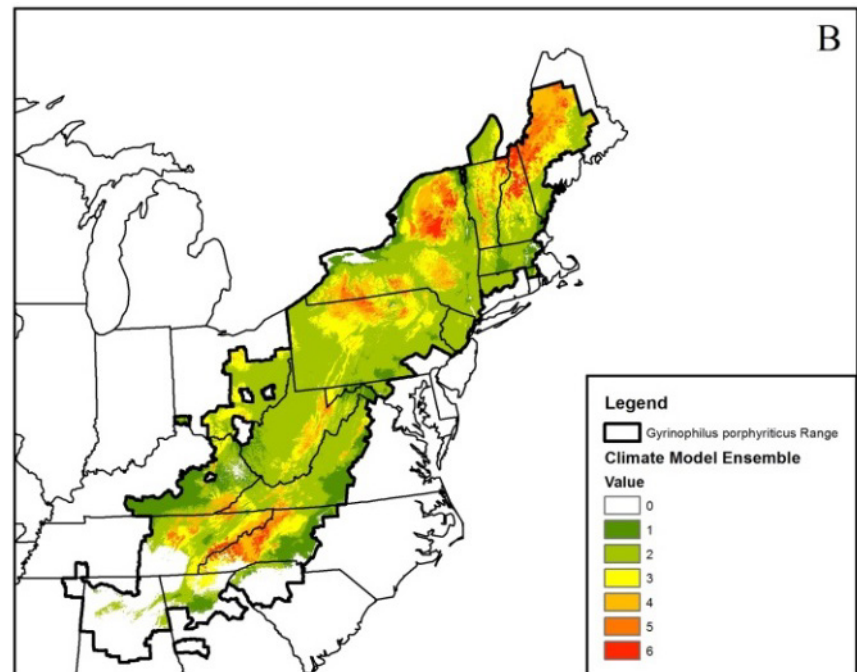
Figure 2. Ensembled climatic distribution within the known geographic range (area with the dark black border) of the Spring Salamander ( Gyrinophilus porphyriticus ) based on two Global Circulation Models (CCSM4 (CCSM) and HadGEMCC-2 (Hadley)) and two Representative Concentration Pathway (RCP) trajectories (RCP 4.5 (Figure 1A) and 8.5 (Figure 1B)) for 2050. The scale of 0–6 in the legend refers to the number of projected models that represent a suitable climatic niche. Areas within the geographic range with no model agreement indicate a climatically unsuitable niche. Maps such as this were generated for all modeled